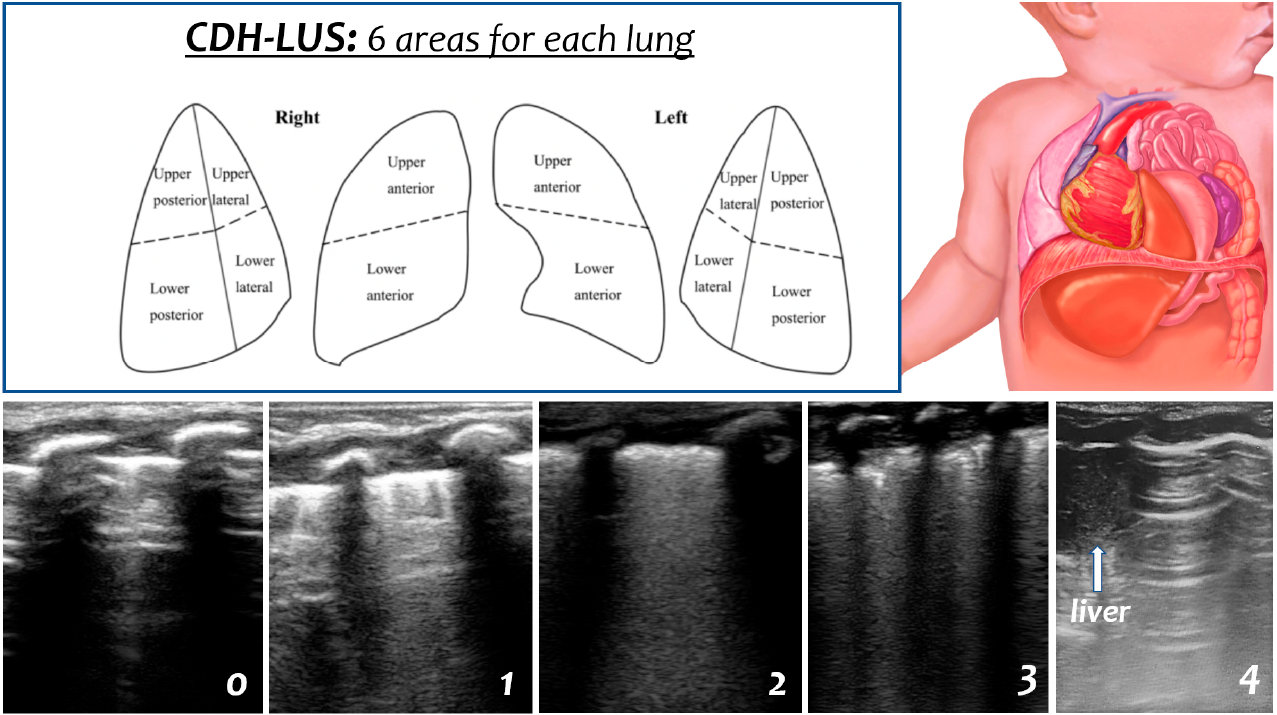
Figure 1. CDH ‐ LUS score description. Each lung is divided into six areas, and a score from 0 to 4 can be given to each scan as follows: 0 indicates an A ‐ pattern (defined by the presence of only A ‐ lines), 1 indicates a B ‐ pattern (defined as the presence of ≥ 3 B ‐ lines), 2 indicates a severe B ‐ pattern (defined as the presence of crowded and coalescent B ‐ lines with or without consolidations limited to the subpleural space), 3 indicates extended consolidations, and 4 indicates the presence of herniated viscera in the hemithorax (liver, small bowel, stomach, or heart in the case of a mediastinal shift) in the preoperative scans and pleural effusions in the postoperative scans.